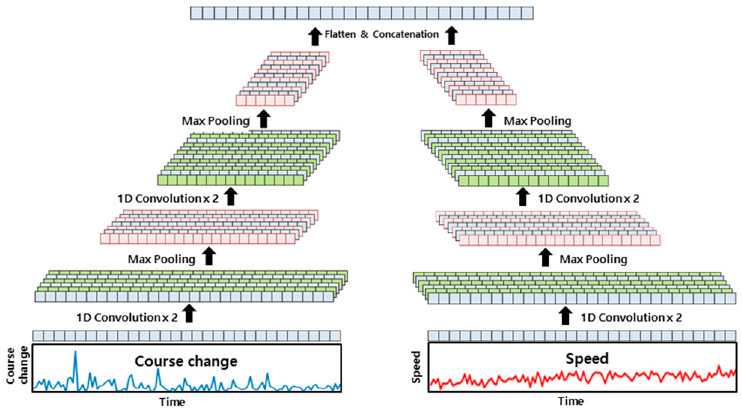
Figure 6. Convolutional neural network (CNN)-based feature extraction module.